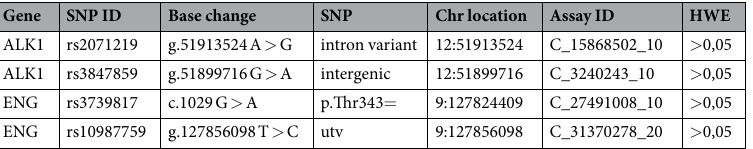
Table 1. Characteristics of the ALK1 and endoglin polymorphisms. Chr: chromosome; HWE: Hardy Weinberg equilibrium in control groups; SNP: single nucleotide polymorphism; utv: upstream transcript variant.